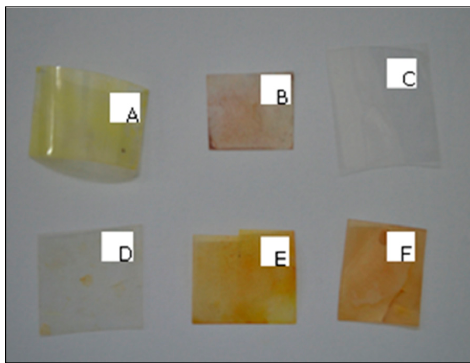
Figure 1. PS films modified with different aminocompounds: aniline ( A ), 3-aminophenol ( B ), 4- aminophenol ( C ), 2-chloroaniline ( D ), o-toluidine ( E ) y 4-nitroaniline ( F ).